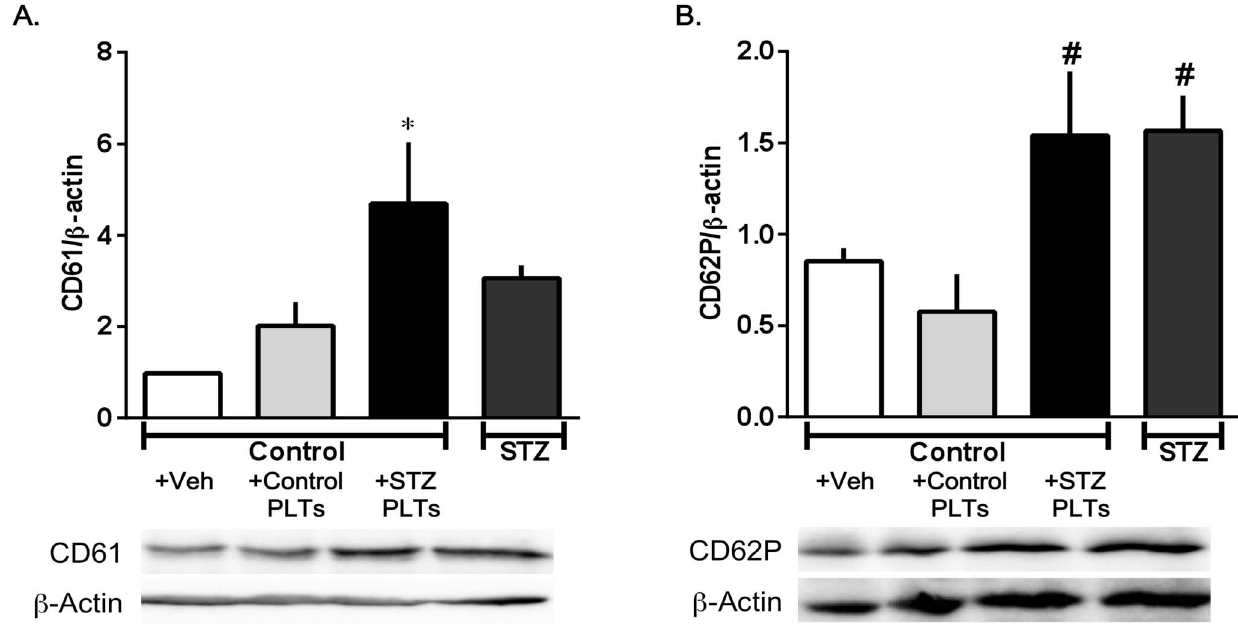
Figure 7. CD61 (A) and CD62P (B) expression in carotid arterial strips from controls. Western blots for CD61 or CD62P in carotid arterial strips from controls treated with PLTs (1.65 6 10 7 cells/mL; 30 min) isolated from control or diabetic rats. Data are means 6 SE; n=5–6; P , 0.05 vs. * + Veh (carotid artery from untreated control) and # + Control PLTs (carotid artery from control treated with control PLTs).